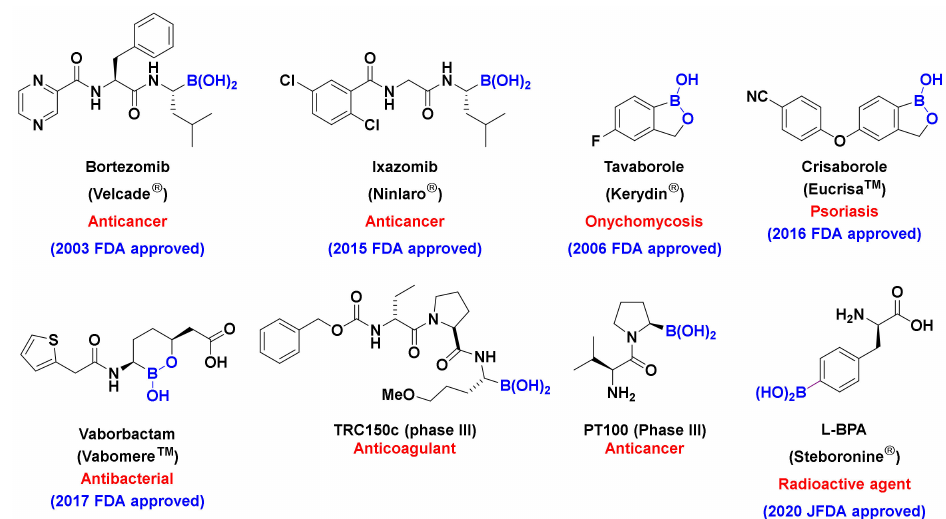
Figure 1. Boron-containing